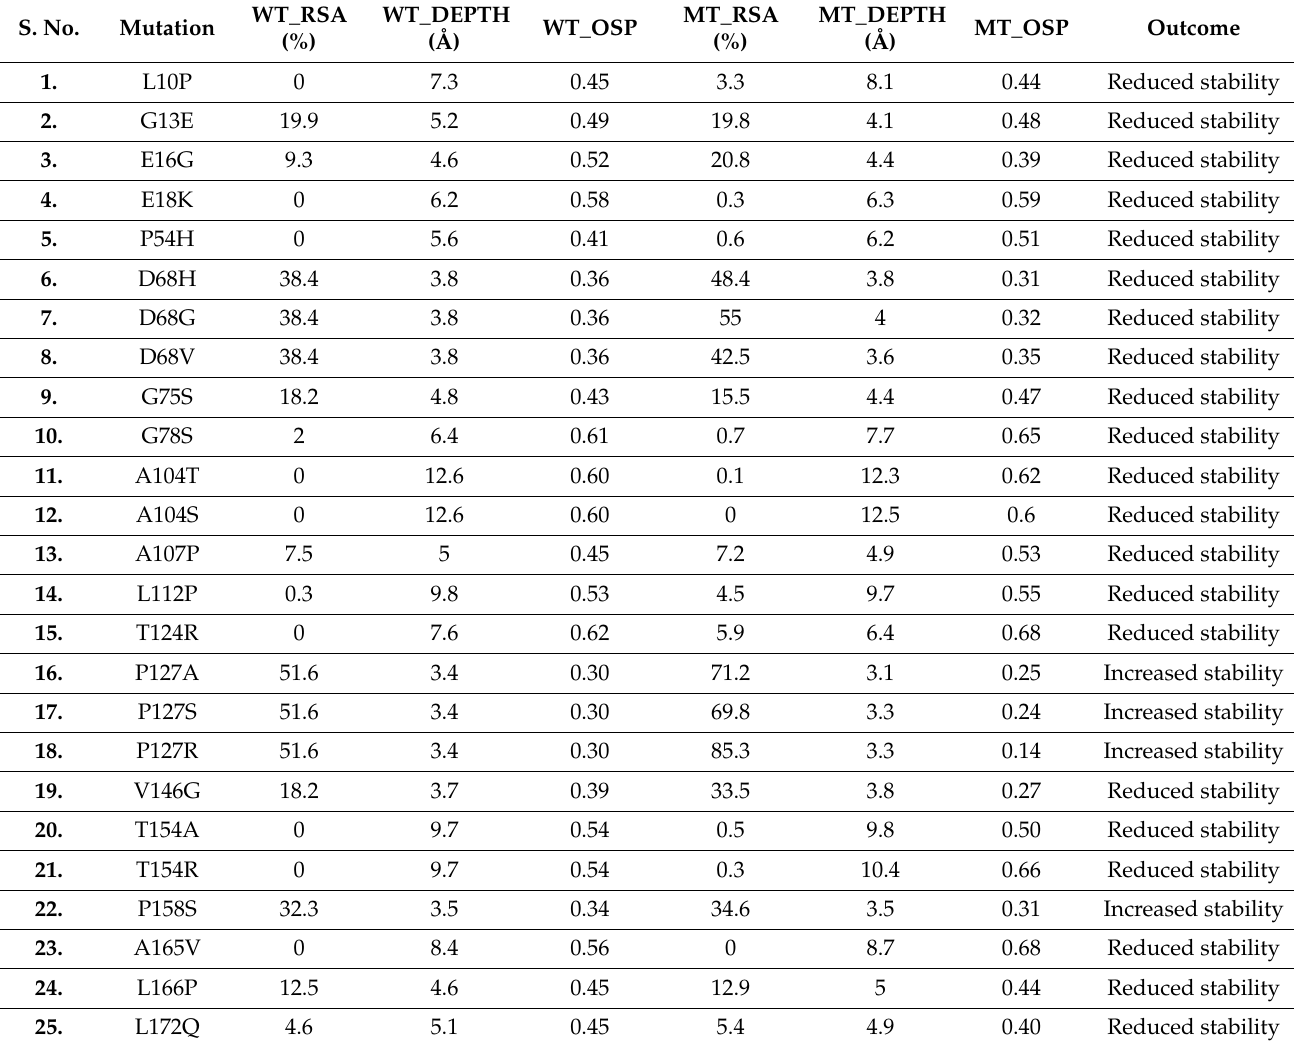
Table 2. RSA, residue depth, and OSP scores of PARK7 mutants predicted through the SDM2 server.